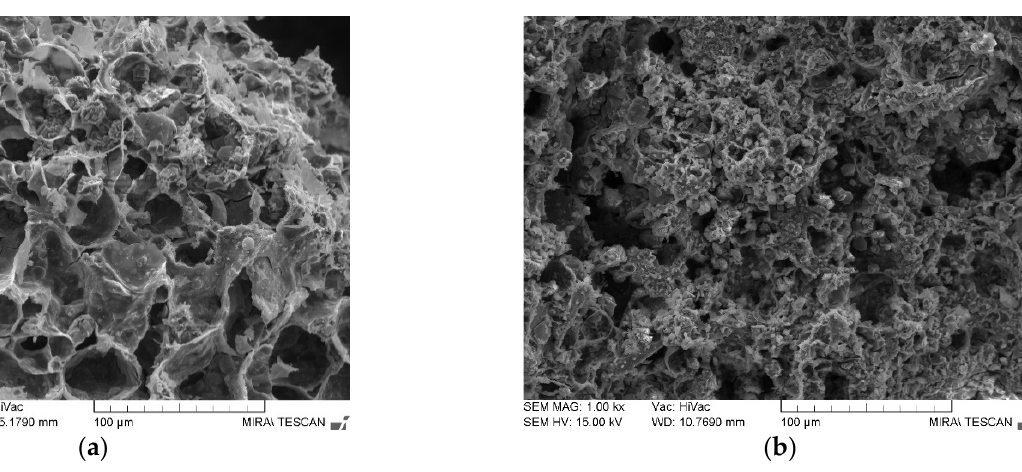
Figure 2. Microstructure of porous geopolymers: ( a ) IC-1SL-Q, ( b ) MK-1SL-Q